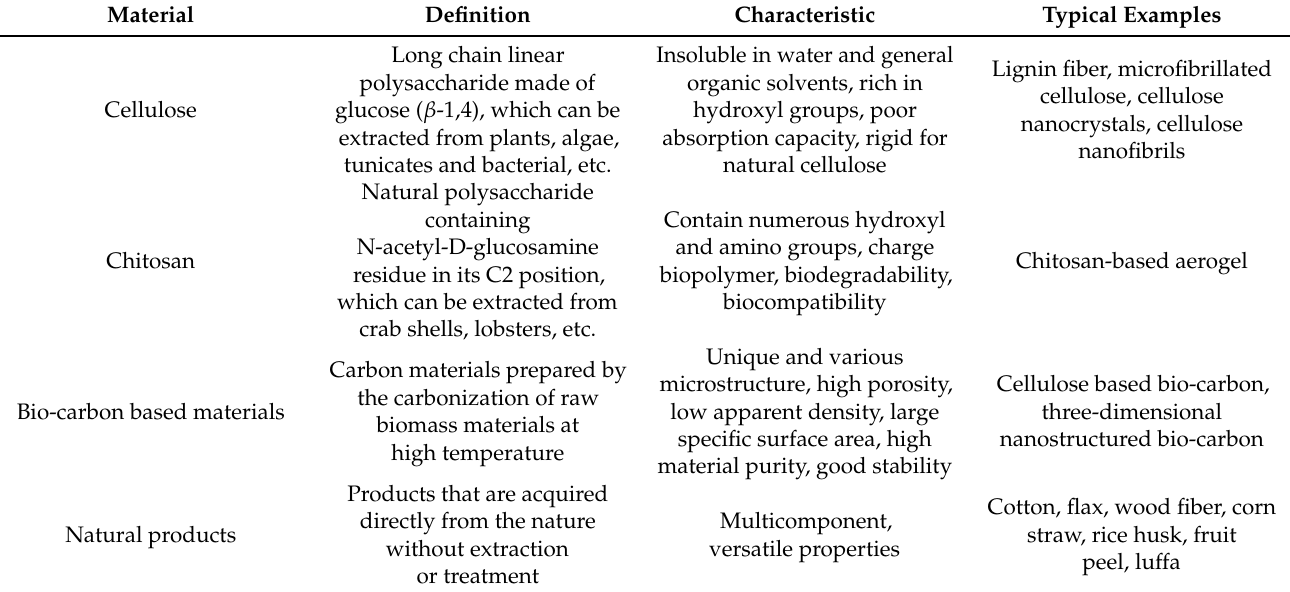
Table 2. Basic information of cellulose, chitosan, bio-carbon based materials and natural